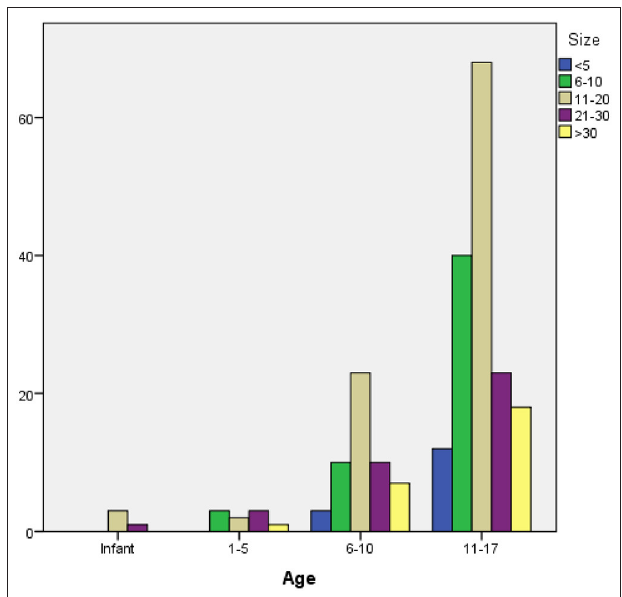
FIGURE 3 | Stone sizes and age groups.